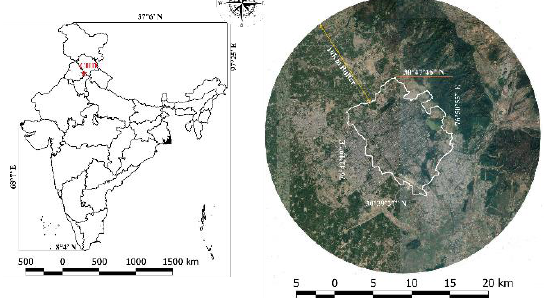
Figure 1: Study area: Chandigarh Municipal Boundary with a